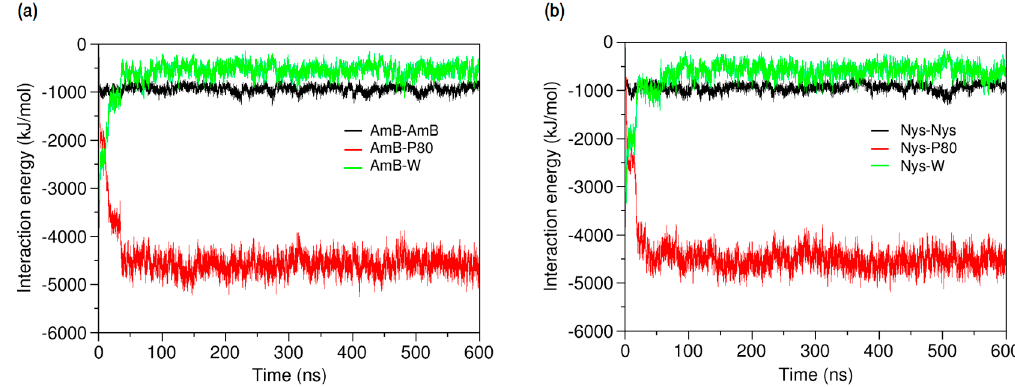
Figure 11. Time-evolution of average energy of interactions ( a ) between AmB and AmB, P80, and water; and ( b ) between Nys and Nys, P80, and water.